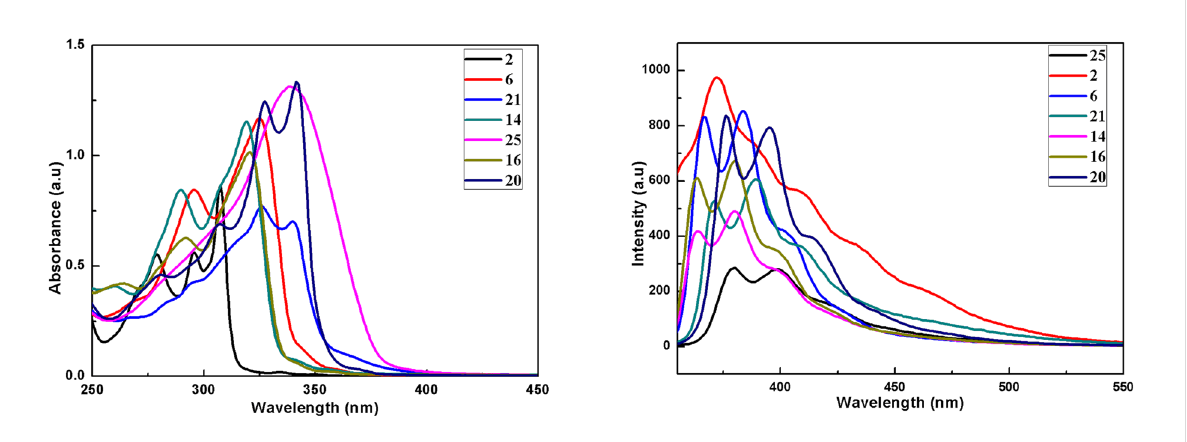
Figure 1: Normalized absorption (left); fluorescence spectra (right) of the synthesized truxene derivatives (7.04 × 10 − 6 M concentration) in